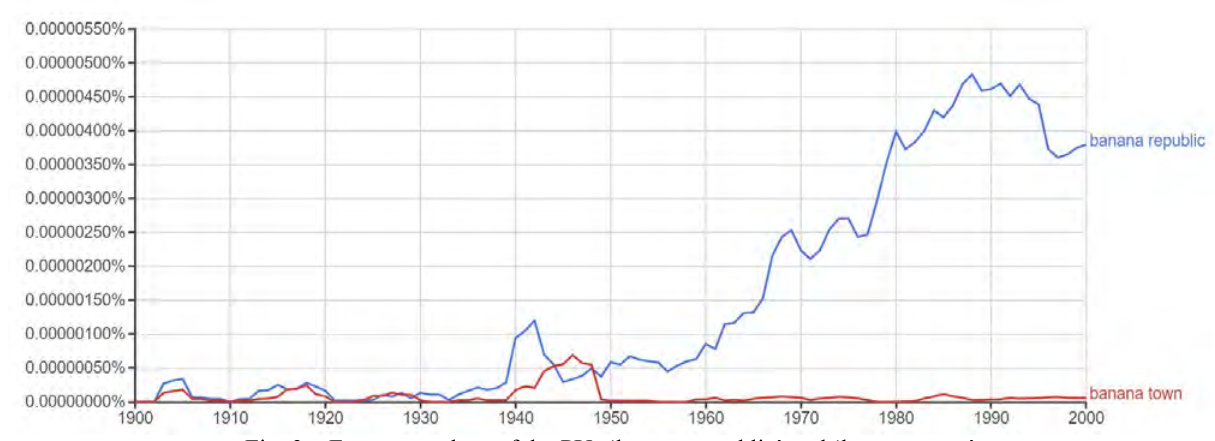
Fig. 3 – Frequency chart of the PUs ‘banana republic’ and ‘banana